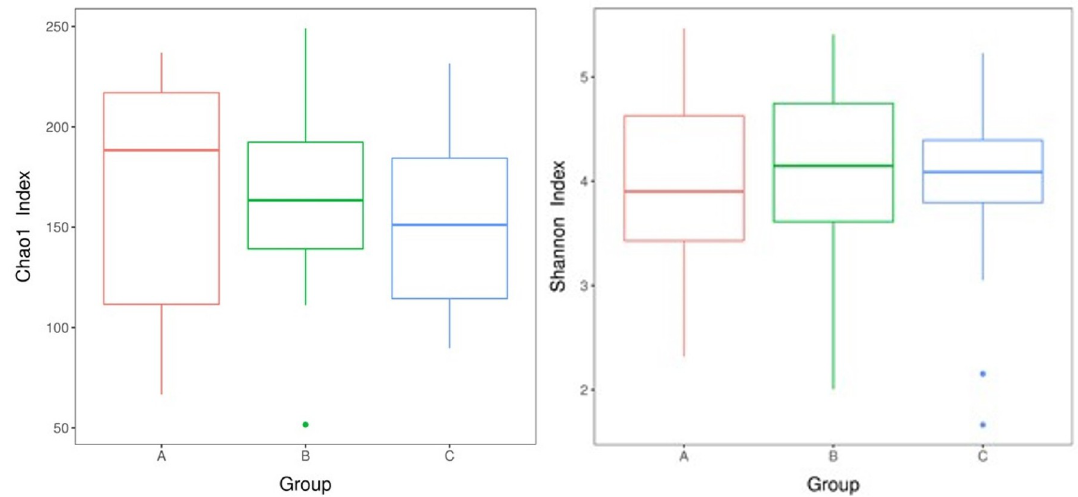
Fig 1. The alpha and beta diversity analyses among three COPD groups. a: Chao1 index boxplot of each group. The X-axis indicates the names of the groups and Y-axis the Chao 1 index. Each box diagram shows the minimum, first quartile, medium, third quartile, and maximum values of the Chao1 index of the corresponding sample; b: Shannon index boxplot of each group; c: PCA score plot. A: stage 1, B: stage 2, C: stage